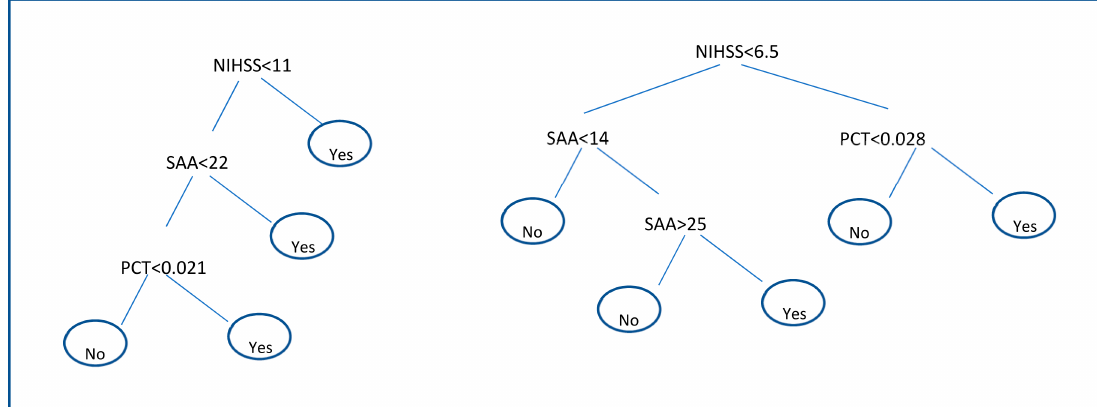
Figure 2. Decision trees applied on the discovery subgroup (left Decision tree) and the Decision Tree applied on the validation subgroup using only biomarkers: SAA and PCT and NIHSS shown on the